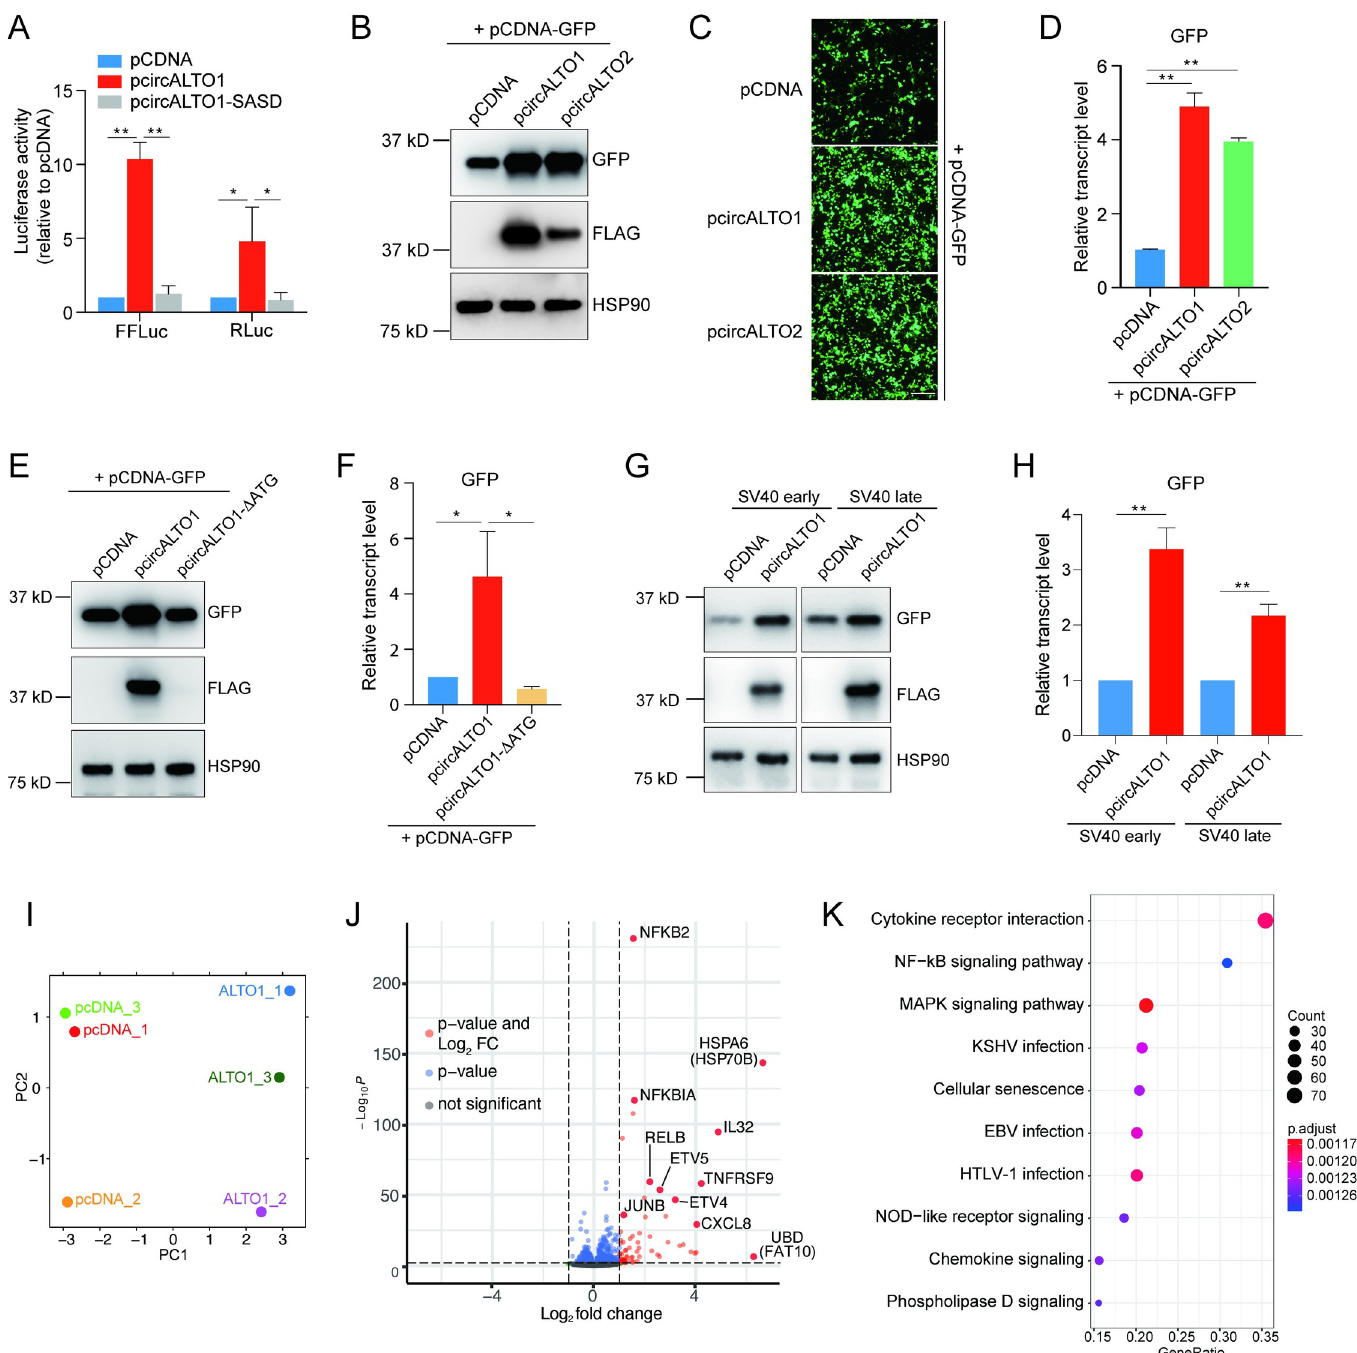
Fig 4. MCPyV circALTO increases transcription from specific promoters and can modulate host cell gene expression. (A) 293 cells were co-transfected with Renilla luciferase reporter or Firefly luciferase reporter and with either pCDNA vector control, pcircALTO1, or pcircALTO1-SASD (n = 3 biological replicates). The P value was determined by unpaired two-tailed t-test. (B) Western blot for GFP and FLAG from 293T cells which were co-transfected with pCDNA-GFP and indicated plasmids including pCDNA control vector, pcircALTO1 (Flag), or pircALTO2 (Flag) plasmids. HSP90 is the loading control. (C) 293T cells were co-transfected with pCDNA-GFP vector and indicated plasmids. IF images are representative of GFP expression after 48 hours. Scale bar = 200 μ m. (D) qRT-PCR analysis for GFP from cells with pCDNA-GFP constructs and indicated plasmids. Expression was normalized against ACTB . Error bar representative of 3 independent experiments. (E) A construct in which all potential ATG start codons have been mutated, circALTO1- Δ ATG, was generated. Western blot for GFP and FLAG from 293T cells were transfected with pCDNA-GFP reporter vector and pCDNA control vector, Flag-circALTO1, and pcircALTO1- Δ ATG plasmids. HSP90 is the loading control. (F) qRT-PCR analysis for GFP transcripts from 293T cells as described in (E). Expression was normalized against ACTB . Error bars = SD from one biological replicate. Results are representative of